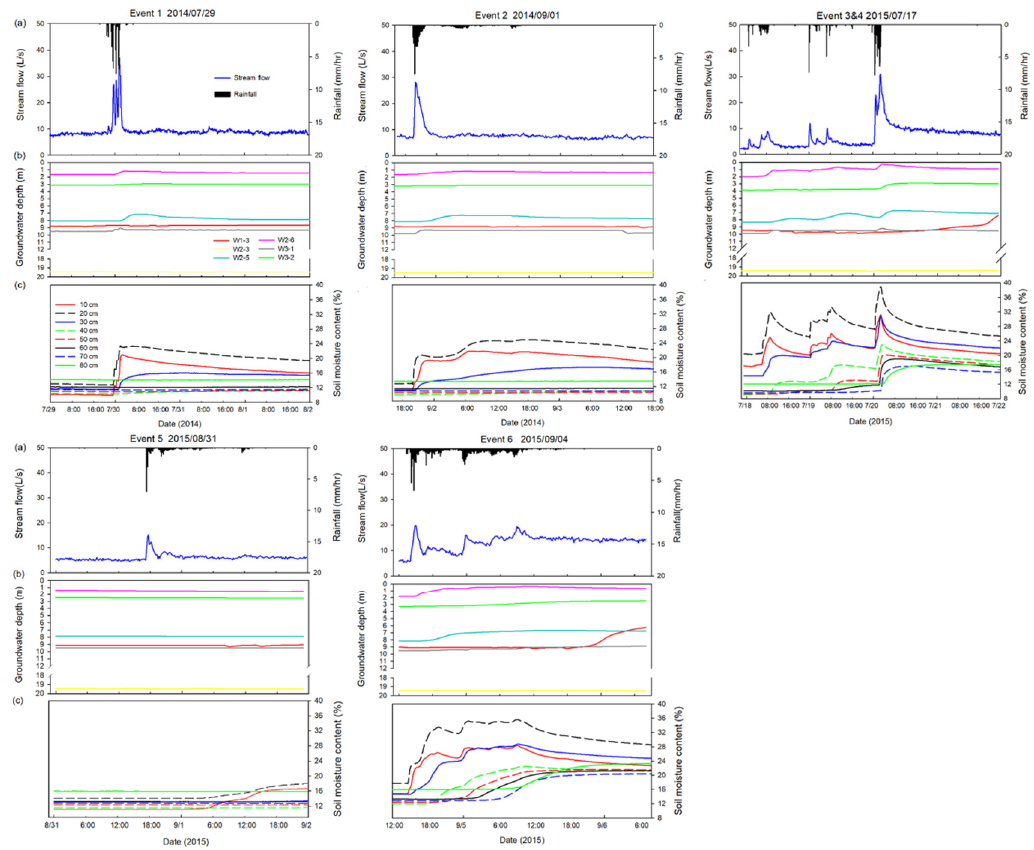
Figure 4. ( a ) Rainfall time series (10-min) and hydrograph. ( b ) Time series of groundwater depth. ( c ) Volumetric water content (VWC, %) for 8 soil depths at Hillslope 1 (soil moisture, Figure 1).